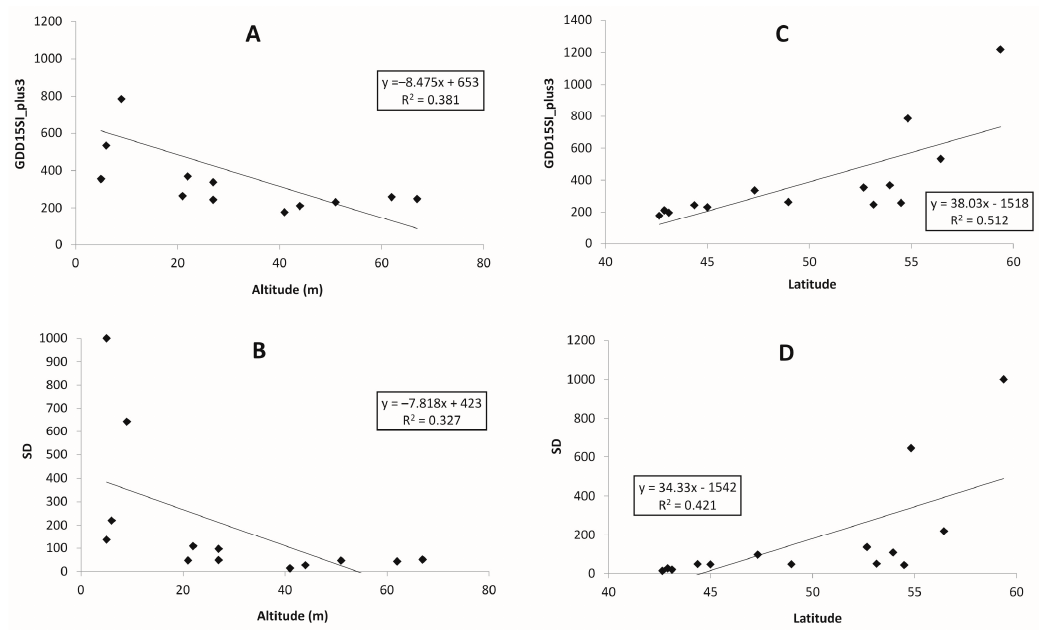
Figure 7. Dependence of Sensitivity Index for growing degree days with 0 °C threshold (GDD0SI) and its standard deviation (SD) for a GDD0 +3 scenario on altitude and latitude for maritime locations in the Russian Far East for the period 1966–2017: ( A , B ) altitude (m), ( C , D ) latitude.